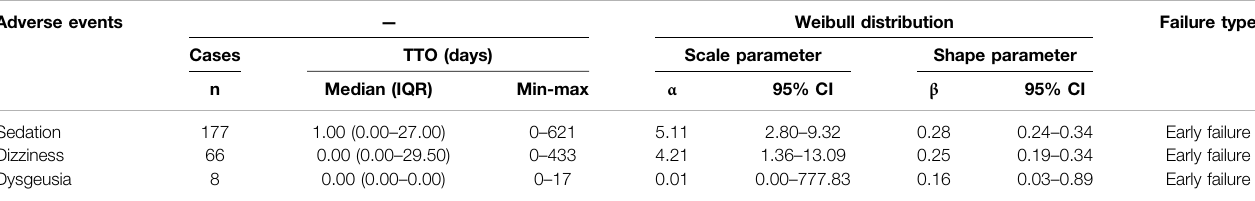
TABLE 4 | The results of time-to-onset analysis for signals with moderate prioritization. Adverse events